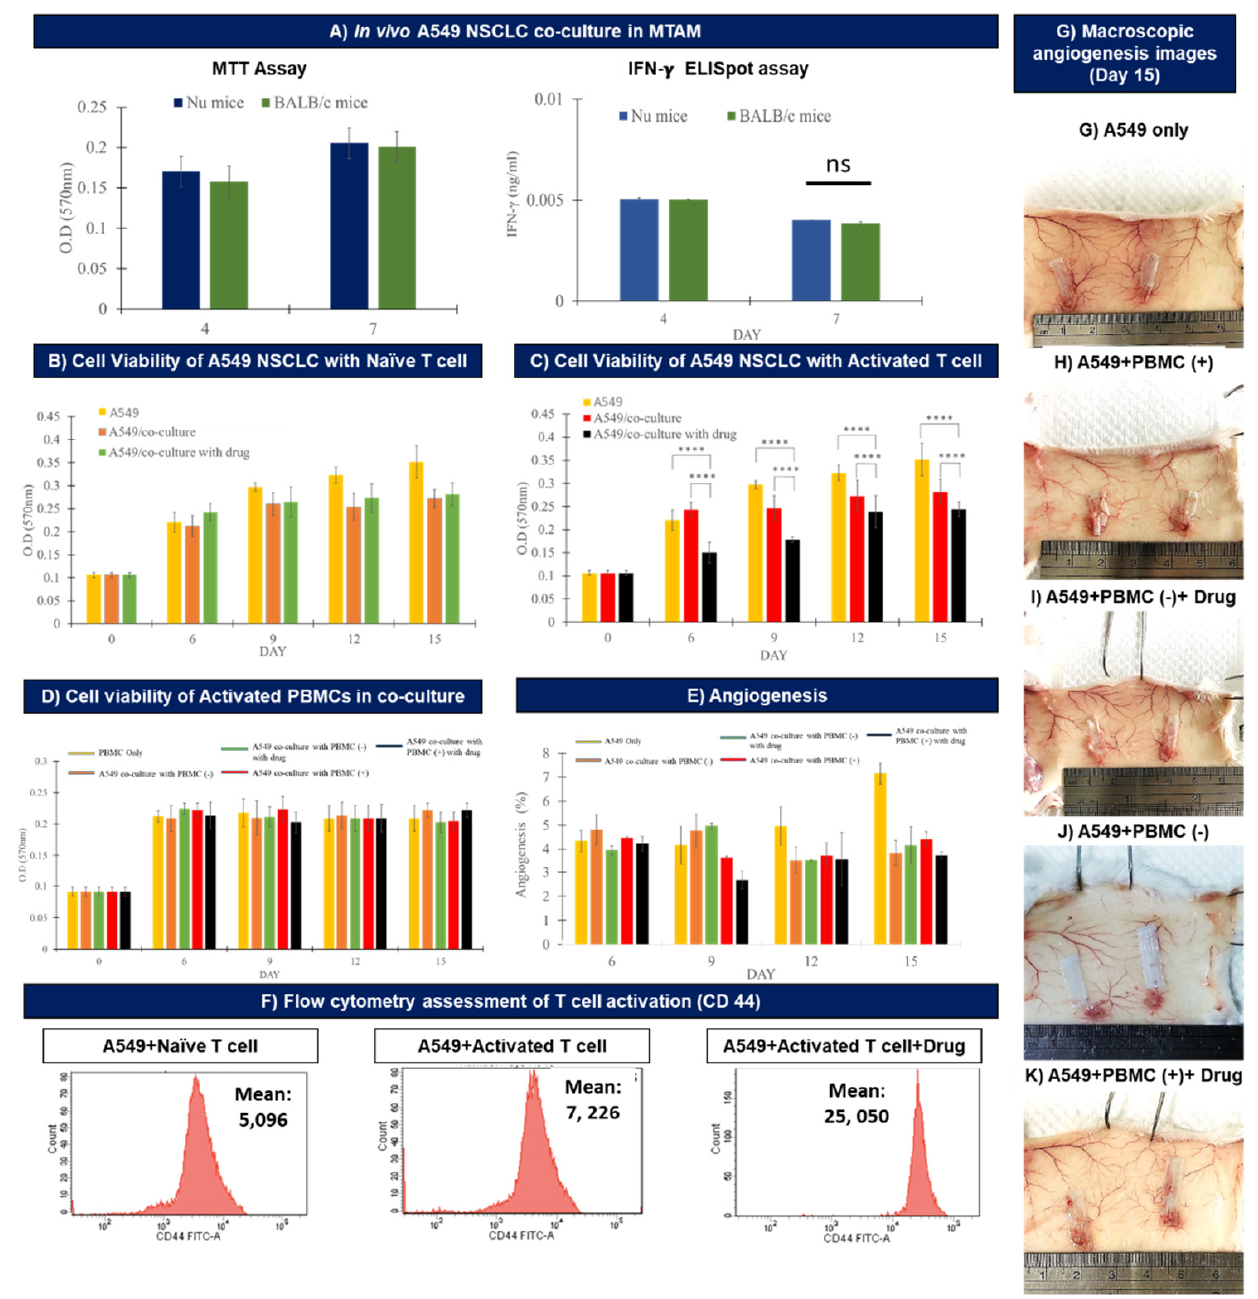
Figure 3. ( A ) Comparison of in vivo co-culture of the A549 cancer cell line within the MTAMs and its corresponding IFN gamma readings when utilizing the immune-compromised mouse and the standard Balb/C mice. No significant differences were found between the utilization of the two variants of mouse models. ( B , C ) In vivo study of the viability of the A549 cancer cell line + PBMCs with non-activated and activated T cells under various settings (monoculture, co-culture and co-culture with drug) (**** equivalent to p -value < 0.0001; ns: not significant). ( D ) Viability of the PBMCs in the monoculture and co-culture setting. ( E ) Angiogenesis degree levels of the subcutaneous blood vessel levels, which coincides with the macroscopic images of ( G – K ). ( F ) Flow cytometer analysis of the T-cell activation utilizing the CD 44 marker.